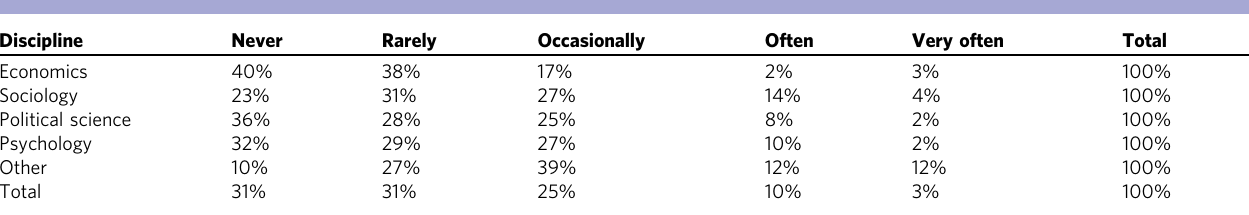
Table 2 Frequency of references to fi ction in publications by